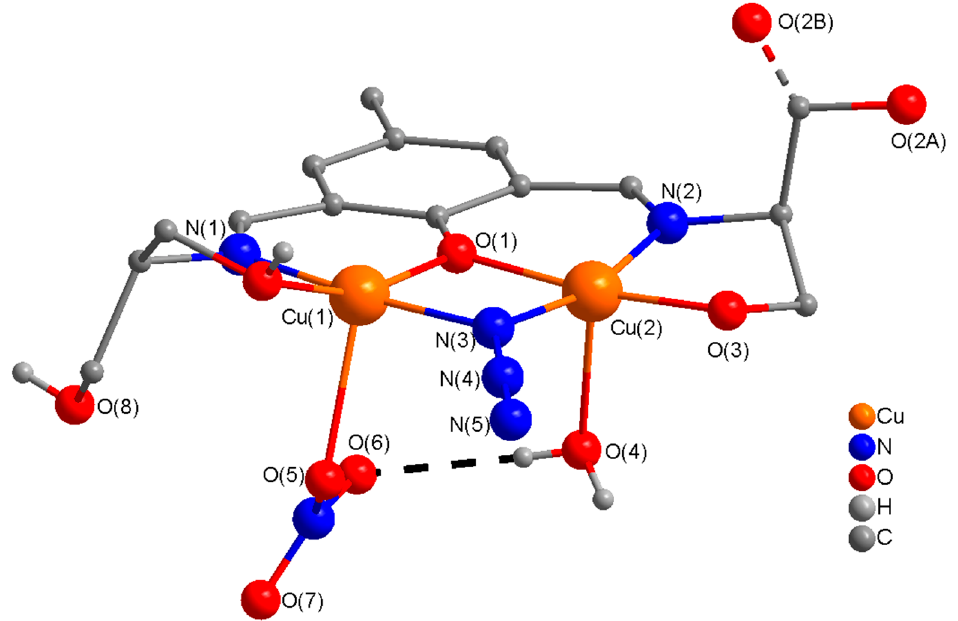
Figure 5. Molecular structure of a dinuclear unit [Cu 2 (H 3 L1 2 − )(H 2 O)(NO 3 )(N 3 )] ( 3 ) with relevant numbering. H-atoms are omitted for clarity.